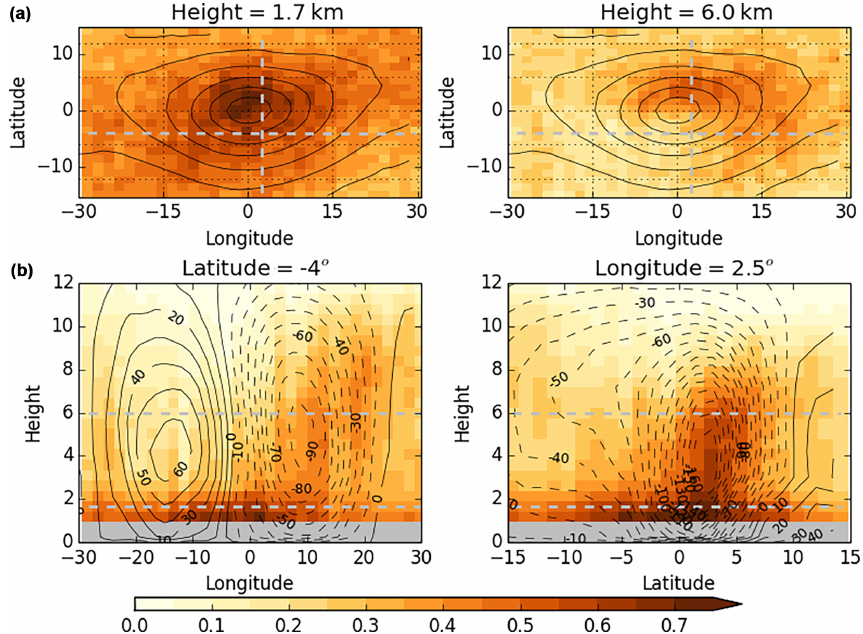
Figure 6. Distribution of average observed hydrometeor (cloud plus precipitation) fraction (colours) around a composite of ERA-I cyclones over Northern Hemisphere oceans for 5 years of DJF daily data. Panel (a) shows horizontal sections through the composite cyclone at 1.7 and 6km with the mean PMSL contoured at 4hPa intervals. Panel (b) shows vertical sections along the grey dashed lines shown in the top plots. Contours on the lower plots are mean vertical velocity from ERA-I (hPad − 1 ; negative values indicate ascent and these contours are